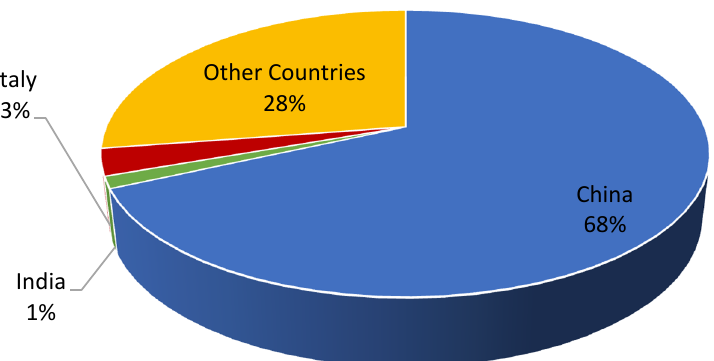
Figure 1. Harvested area of pear ( top ) and total production ( bottom ) in the top 3 countries and the world.